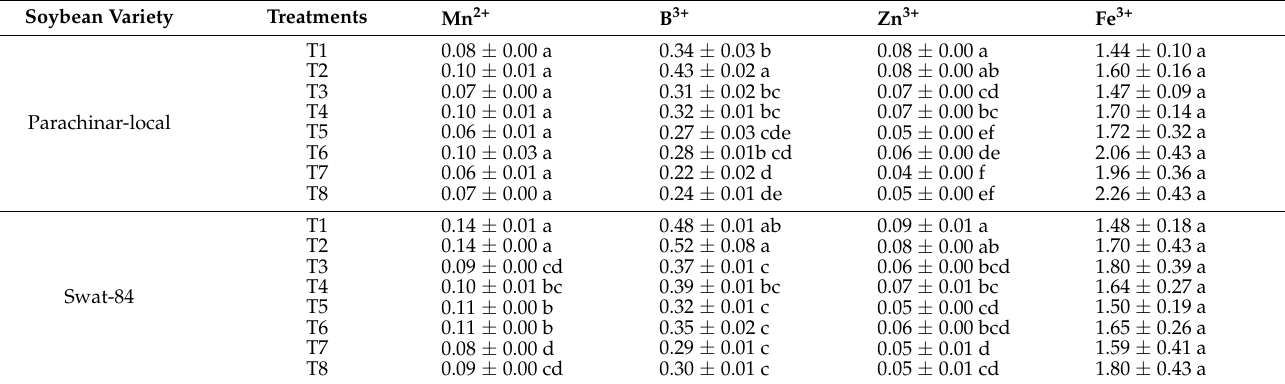
Table 5. Changes in foliar cations concentration of both